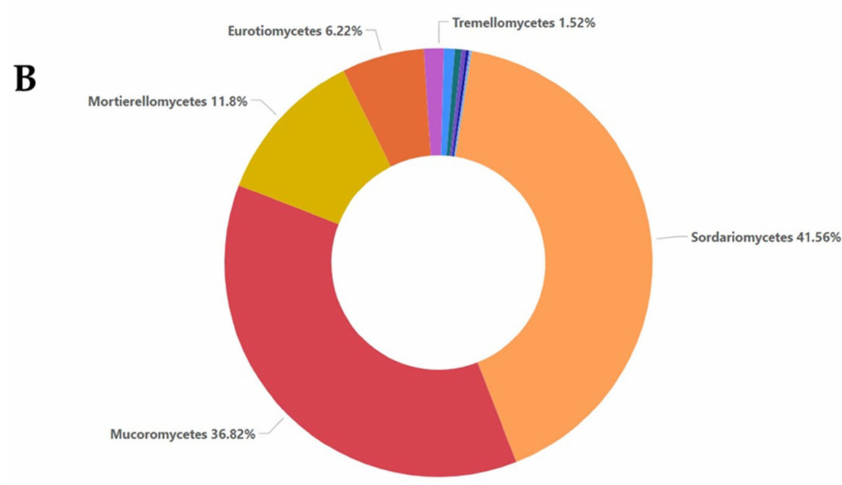
Figure 2. Relative abundance with percentages above 1% for the class taxa, as shown for the non- inoculated samples ( A ) and inoculated samples ( B ).